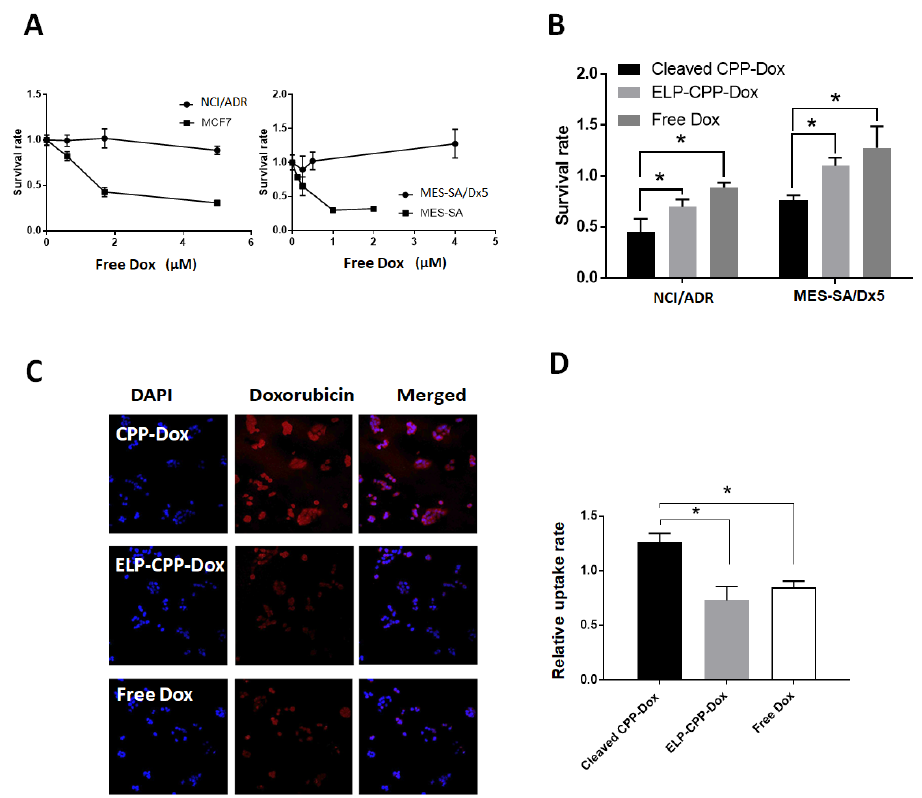
Figure 4. Cytotoxicity of CPP-Dox against Dox-resistant cancer cells. ( A ) Free Dox killed Dox-sensitive cancer cells (MCF7 and MES-SA), while it spared Dox-resistant NCI/ADR and MES-SA/Dx5. ( B ) Cytotoxicities of CPP-Dox and ELP-CPP-Dox in NCI/ADR and MES-SA/5DX at 4 µ M Dox equivalence. ( C ) Confocal microscopic images show that CPP-Dox penetrated into NCI/ADR. ( D ) Flow cytometry, 60% increased uptake in CPP-Dox in comparison with ELP-CPP-Dox and free Dox. * p < 0.05.